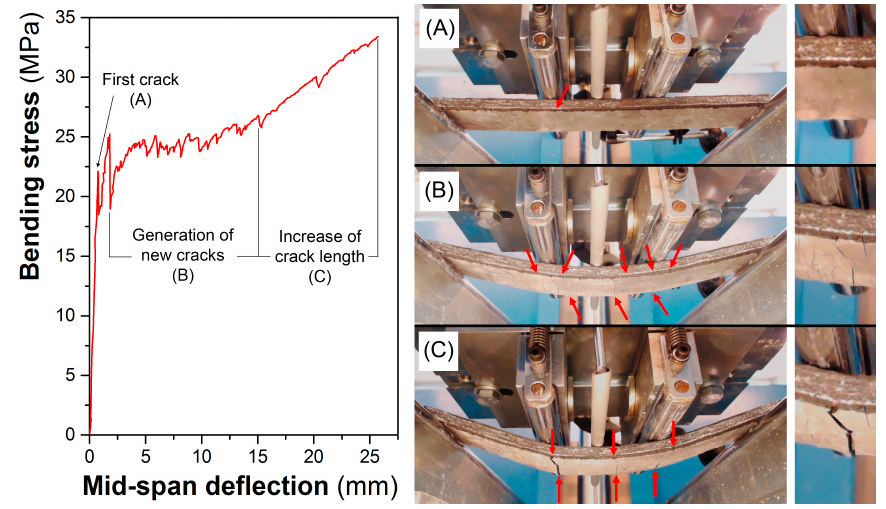
Figure 3. Representative curve and cracking phases of the composites obtained under flexural stress: ( A ) first crack; ( B ) generation of new cracks; ( C ) increase of crack length.